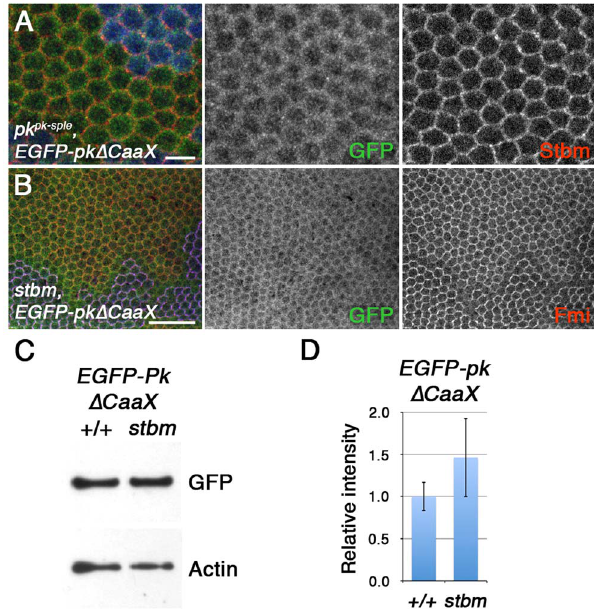
Figure 6. Farnesylation is required for Stbm to promote Pk recruitment to junctions and Pk degradation. (A) High magnifi- cation image of pk pk-sple13 pupal wing clone, marked by loss of ß-gal staining (blue), in wings expressing ActP-EGFP-pk D CaaX . Staining is for GFP (green) and Stbm (red). Scale bar 5 m m. (B) stbm 6 pupal wing clone, marked by loss of Stbm (blue) staining, in wings expressing ActP-EGFP- pk D CaaX . Staining is for GFP (green) and Fmi (red). Scale bar 20 m m. (C,D) Western blot (C) and quantitation (D) of GFP levels relative to Actin levels, in 28 hr pupal wing extracts from ActP-pk D CaaX/ + and pActP-pk D CaaX/ + ; stbm 6 flies. Quantitation from 3 biological replicates, error bars are s.e.m., p=0.40.